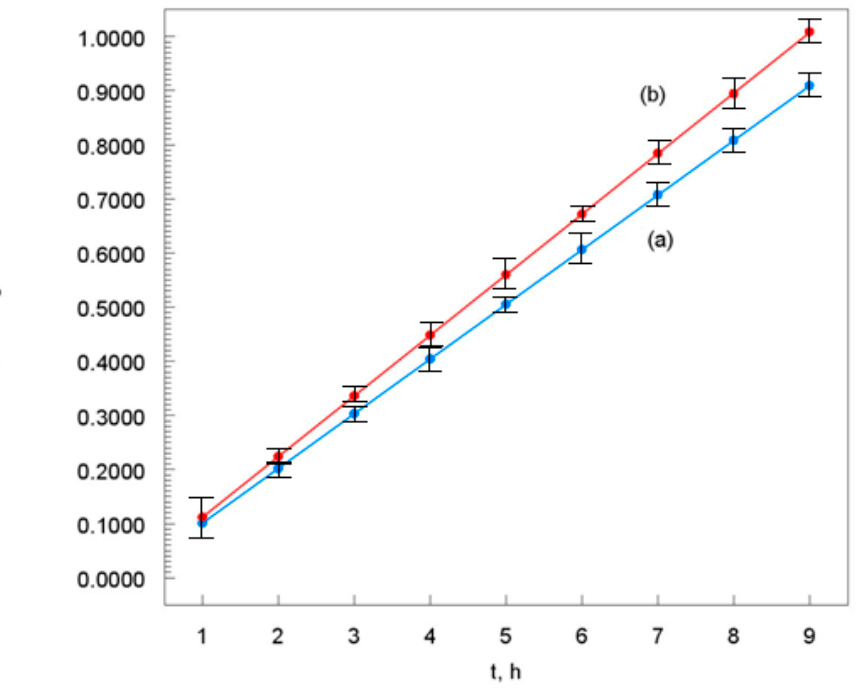
Figure 6. Influence of exposure time on mass change of Al/Cu alloy during heat treatment at: ( a ) 400 °C or ( b ) 600 °C in air atmosphere. Exposure time 9 h.